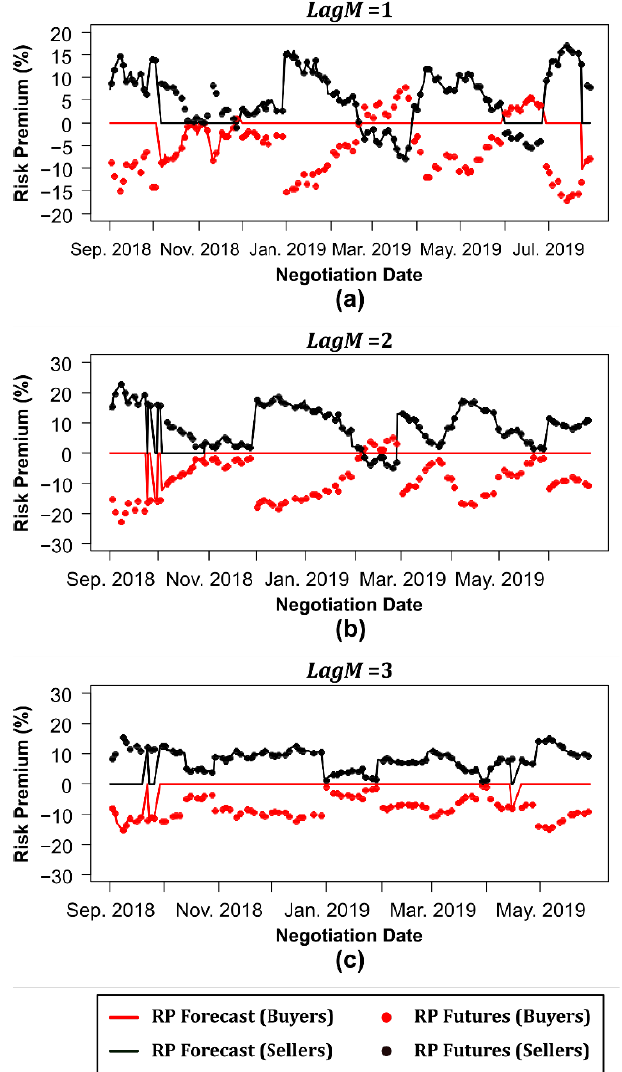
Figure 5. Risk Premium values for buyers and sellers following the predictive (RP Forecast) and the conventional (RP Futures) strategies: (a) for LagM = 1, (b) for LagM = 2 and (c) for LagM = 3. conventional (RP Futures) strategies: ( a ) for LagM = 1, ( b ) for LagM = 2 and ( c ) for LagM =